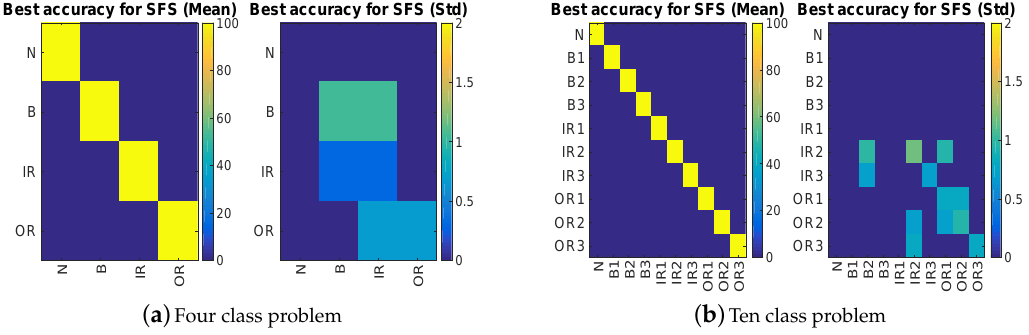
Figure 5. Confusion matrix results using the SFS approach. The mean of the confusion matrix ( left ) and the standard deviation of the confusion matrix ( right ) along the cross-validation folds are